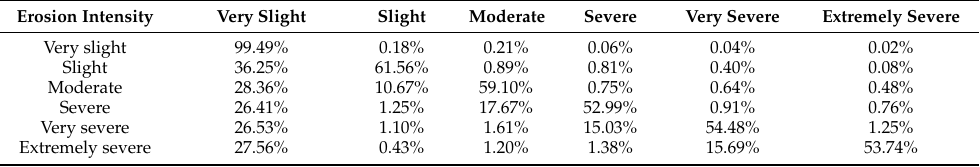
Table 4. Soil erosion intensity transfer rate on the Loess Plateau,